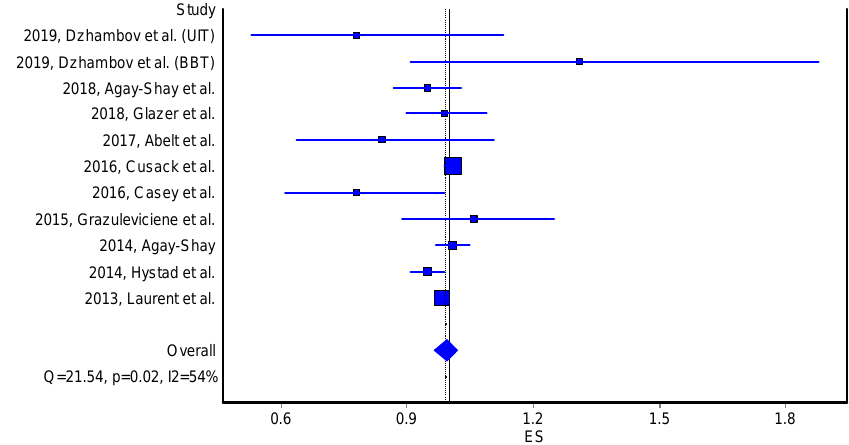
Figure 4. Forest plot on the effect of residential greenness (NDVI) on preterm birth (odds ratio, quality effects model). Note: ES—effect size; Q and I2 —heterogeneity statistics. Horizontal lines, square and diamond symbols are indicating confidence intervals, effect estimates and overall effect, respectively.